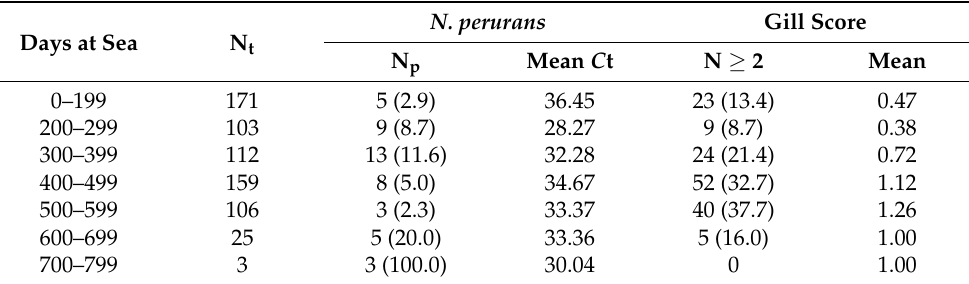
Table 3. The effect of days at sea on infection with Neoparamoeba perurans and mean gill score in farmed Atlantic salmon ( Salmo salar ) in British Columbia, Canada between 2016 and 2020 (see text).